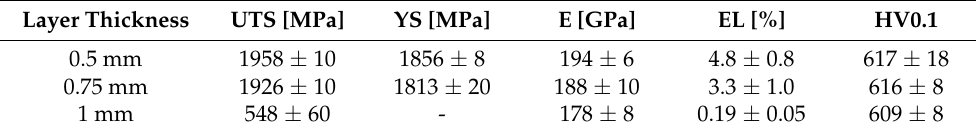
Figure 8. Graph of the microhardness distribution along samples.